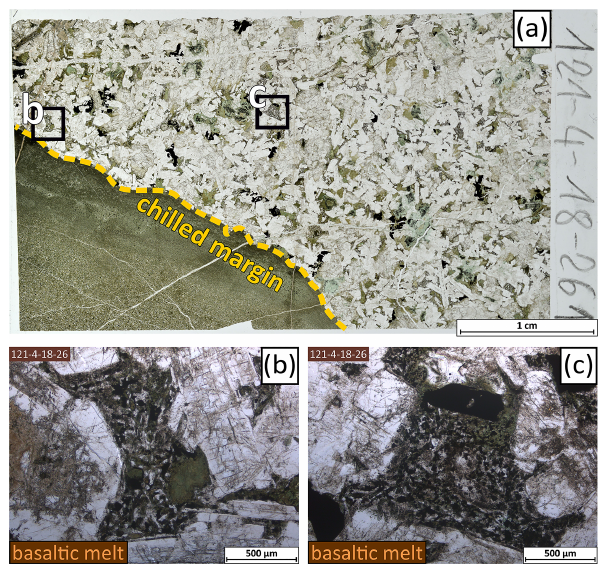
Figure 6. (a) Thin-section photo of sample GT3A-121Z-4, 18– 26cm showing a contact between a varitextured gabbro and a basalt. The basalt at the contact shows a chilled margin, where the basalt coarsens gradually at increasing distance from the margin. (b– c) The basalt infiltrated the gabbro expressed by numerous pools of interstitial basaltic melts within the gabbro. All images in plane- polarized